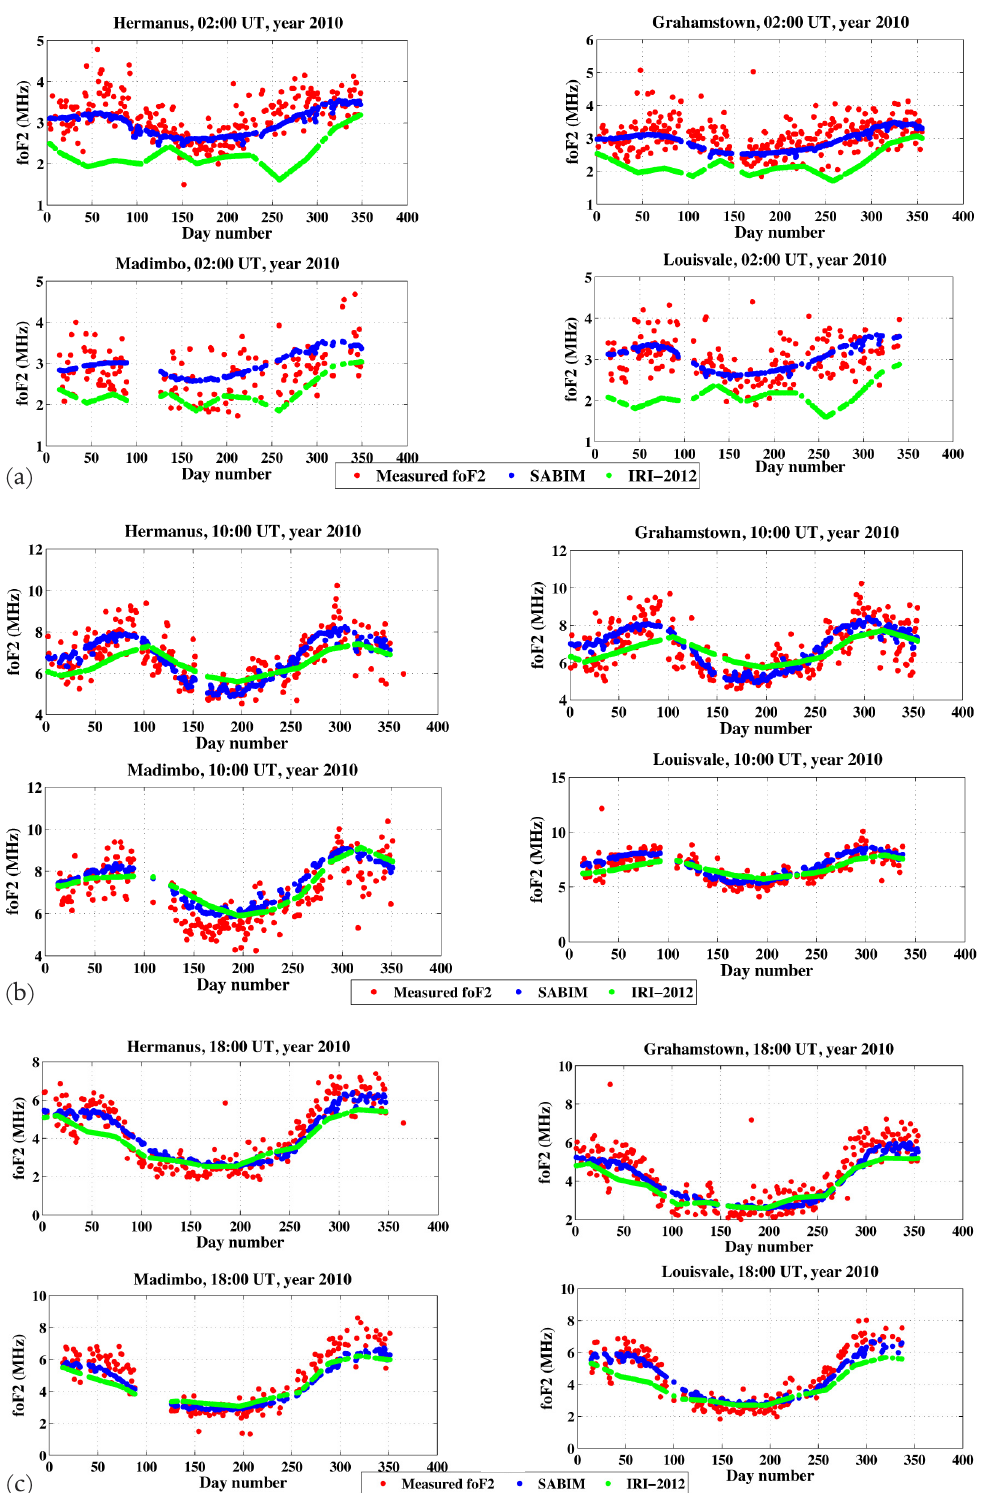
Figure 3. Annual variation of foF2 values from the ionosondes (Hermanus, Grahamstown, Louisvale and Madimbo), the SABIM model and the IRI-2012 model. (a) Before sunrise 02:00 UT (04:00, SAST), (b) local noon 10:00 UT (12:00, SAST) and (c) after sunset 18:00 UT (20:00,